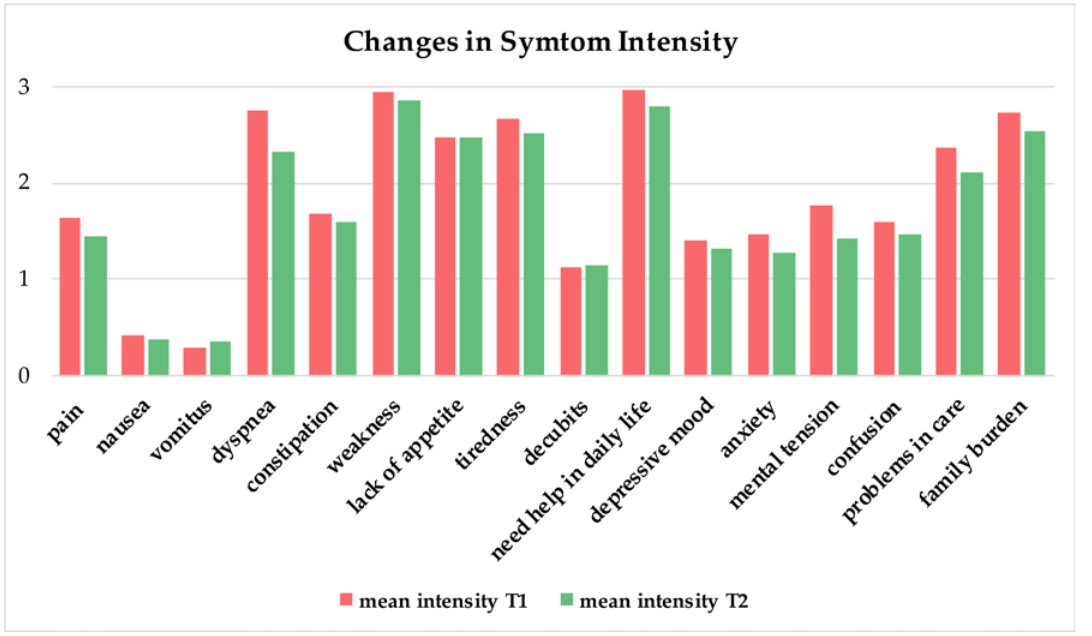
Figure 3. Changes in the mean values of each symptom intensity from the beginning (T1) to the end (T2) of specialist palliative care involvement (0 = no symptoms, 1 = light symptoms, 2 = moderate symptoms and 3 = severe symptoms).